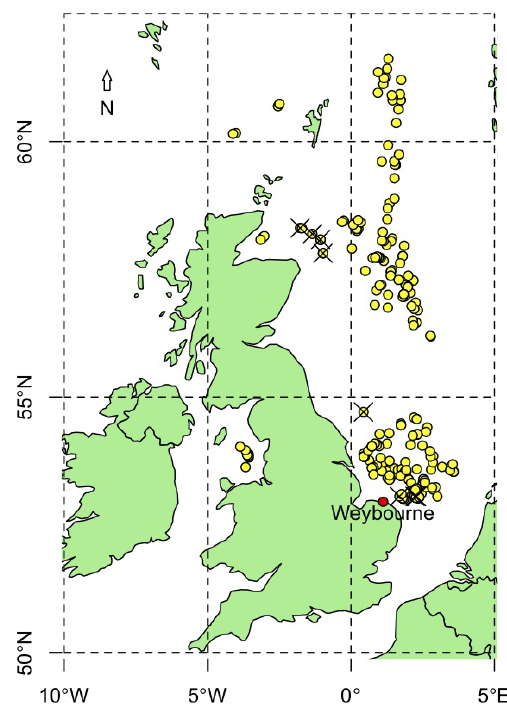
Figure 1. Map of the North Sea showing the locations of all UK off- shore oil and gas platforms (the filled yellow circles) and the eight platforms measured by this study (black crosses) (source: OSPAR, 2012). The map also shows the location of the University of East Anglia’s Weybourne Atmospheric Observatory (WAO; 52.95 ◦ N, 1.14 ◦ E) in Weybourne, Norfolk,